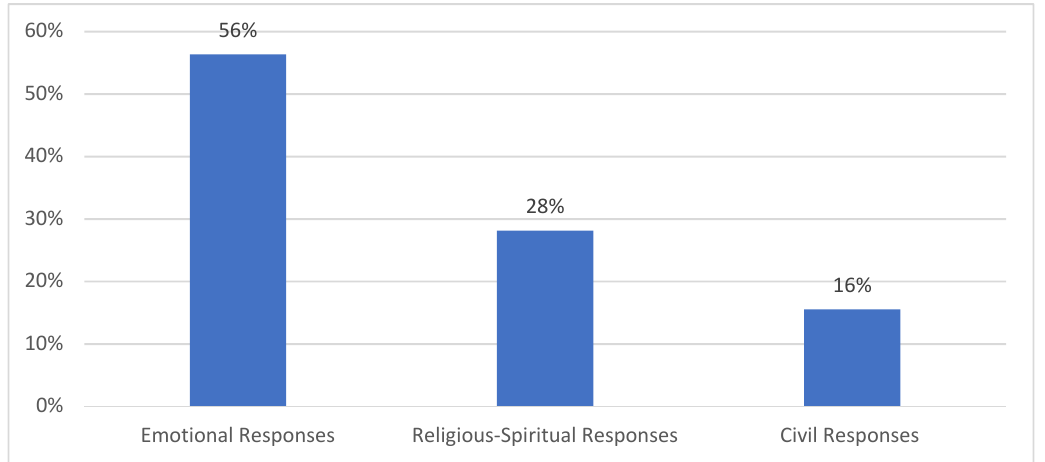
Figure 1. Categorization of the Responses to the Meron Crowd Crush by Clusters (N =